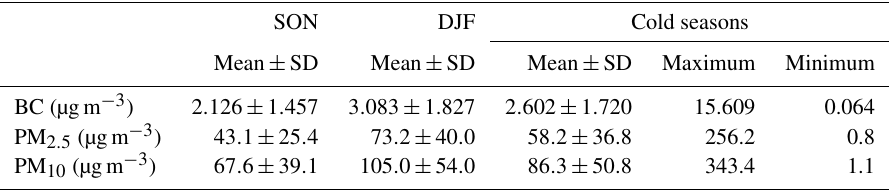
Table 3. Statistics of the three particles during the study period at the Gulou site. SON